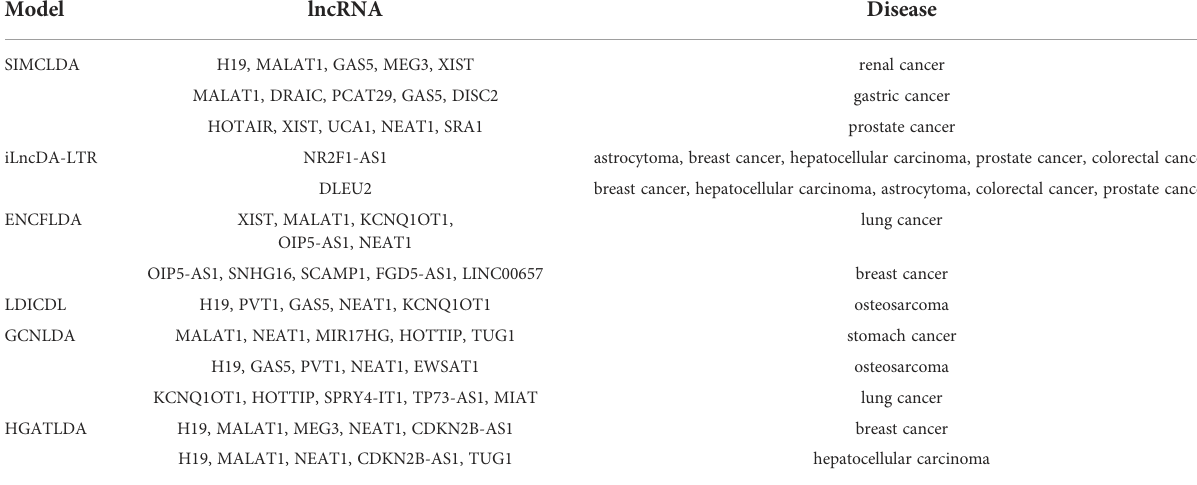
TABLE 2 The top 5 lncRNA-disease associations that have been successfully experimentally con fi rmed in case studies of various machine learning models.